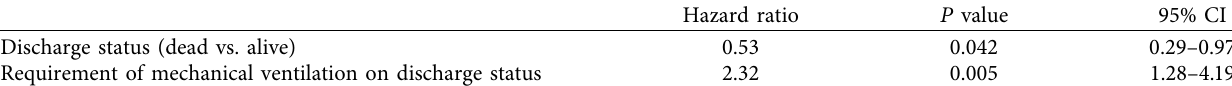
Table 2: Primary outcomes.